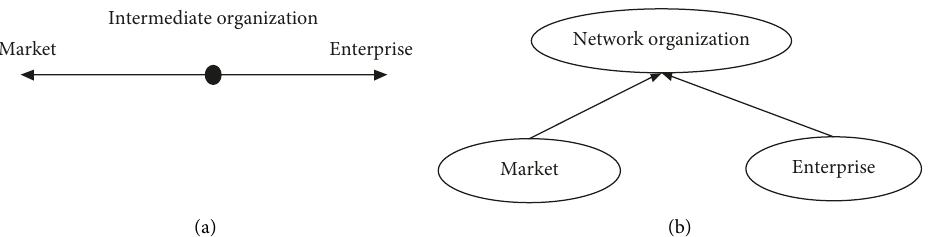
Figure 1: Three types of organizational evolution. (a) Linear evolution of three kinds of organizations. (b) Nonlinear evolution of three kinds of